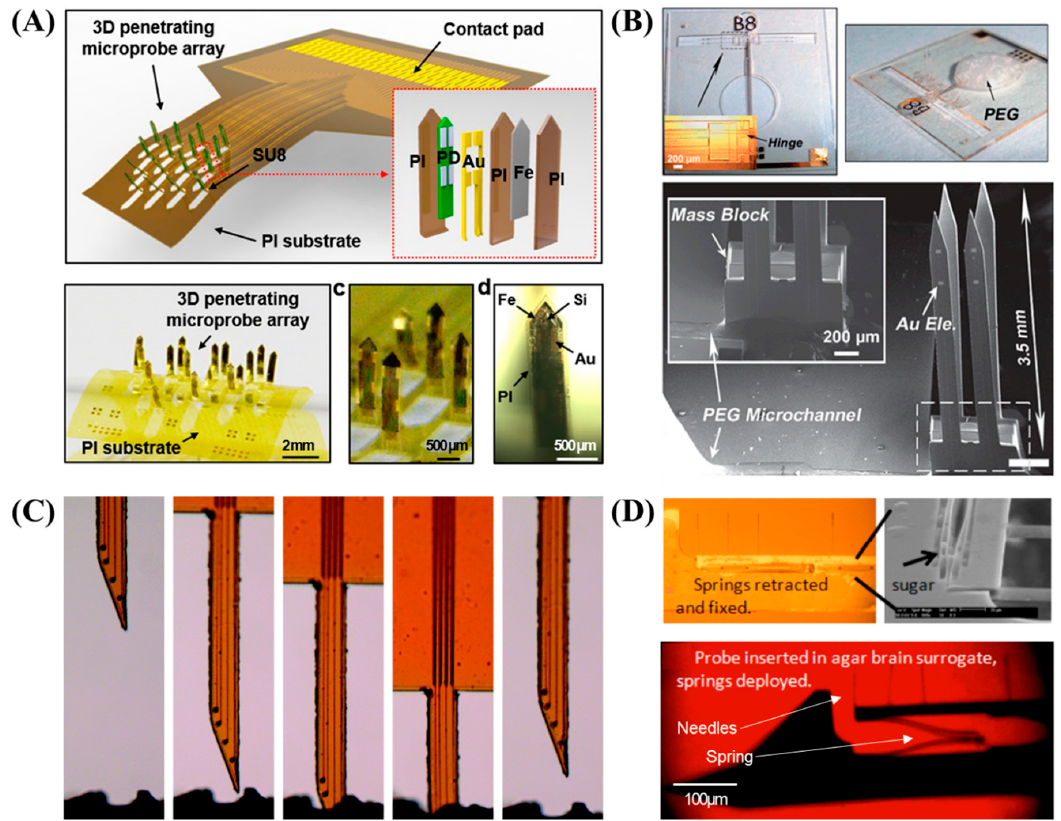
Figure 3. ( A ) Polyimide optrode array folded using magnetic force (reproduced from [153] with permission from Springer Nature, copyright 2018. Creative Commons Attribution 4.0 International License: http://creativecommons.org/licenses/by/4.0/); ( B ) neural probe consisting of a SU-8 shank and a parylene hinge and folded using electrostatic force (reproduced from [151] with permission of The Royal Society of Chemistry); ( C ) probe based on a ternary thiol-epoxy/maleimide network for softening after implantation (reproduced from [159] with permission of The Royal Society of Chemistry); ( D ) silicon neural probe with satellite recording sites that can be self-deployed